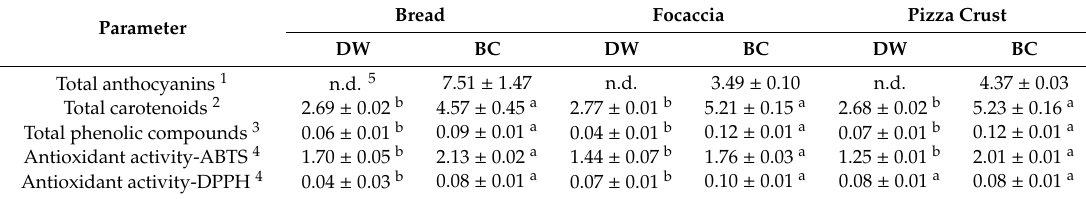
Table 6. The bioactive compounds and antioxidant activity of conventional durum wheat bread, focaccia, and pizza crust and of their black, chickpea-enriched versions. DW = product prepared by using durum wheat re-milled semolina; BC = product prepared by using a composite meal containing